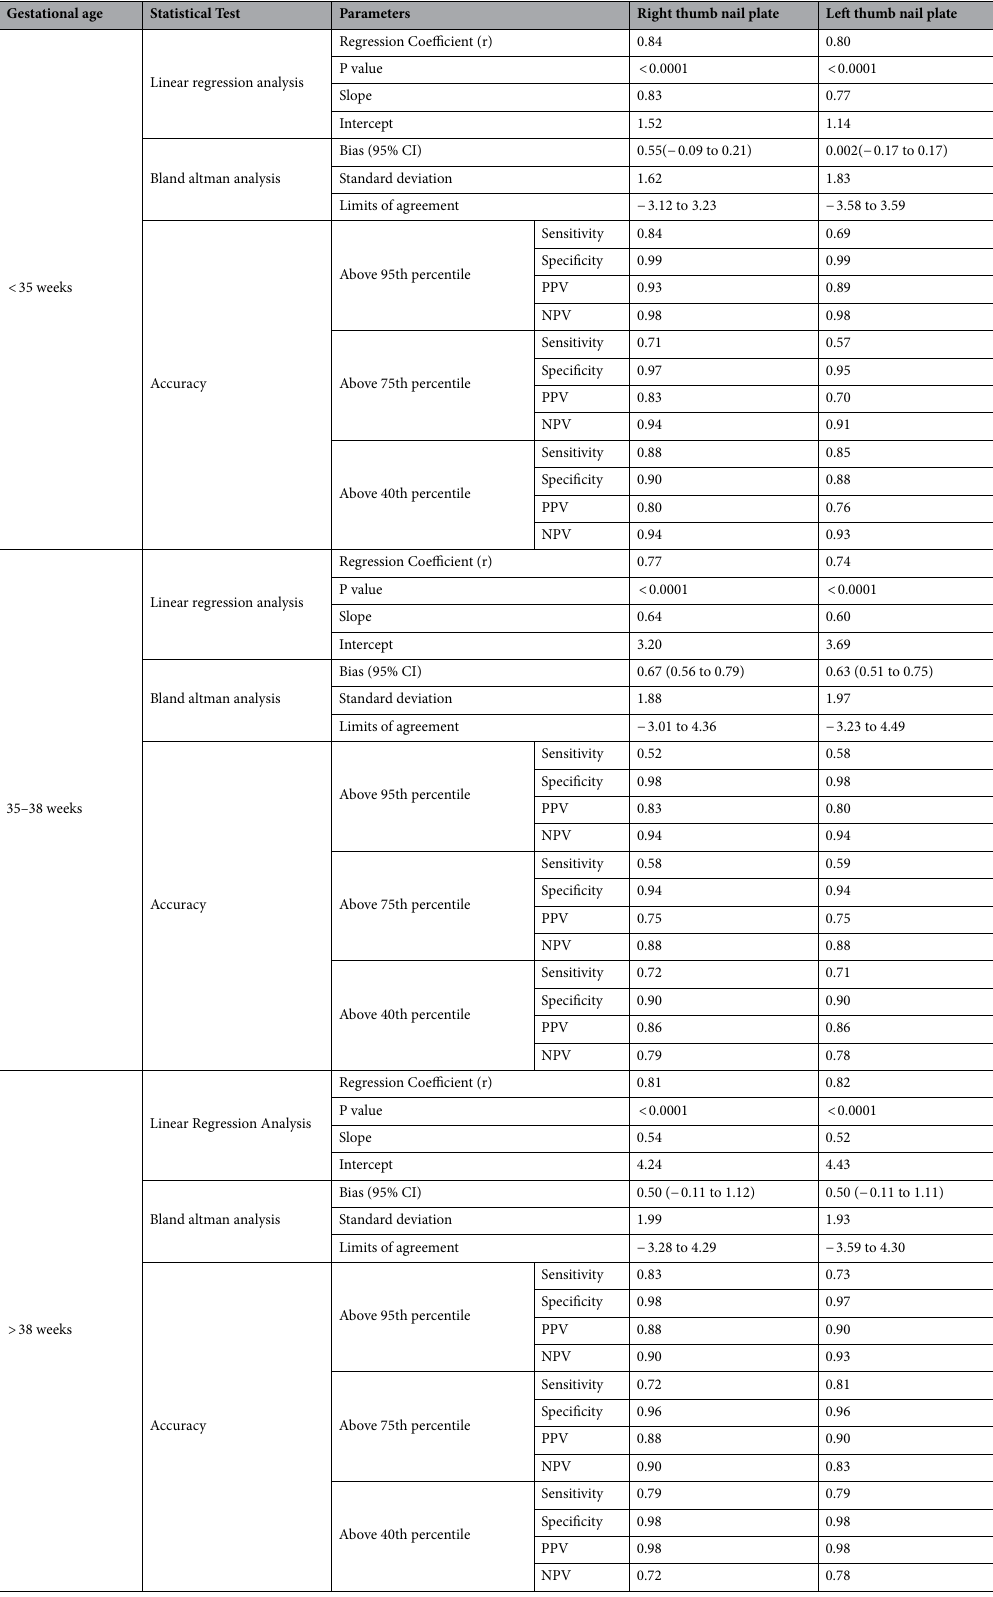
Table 2. Effect of gestational age in the correlation between bilirubin values obtained from AJO-Neo and TSB and the predictive indices of